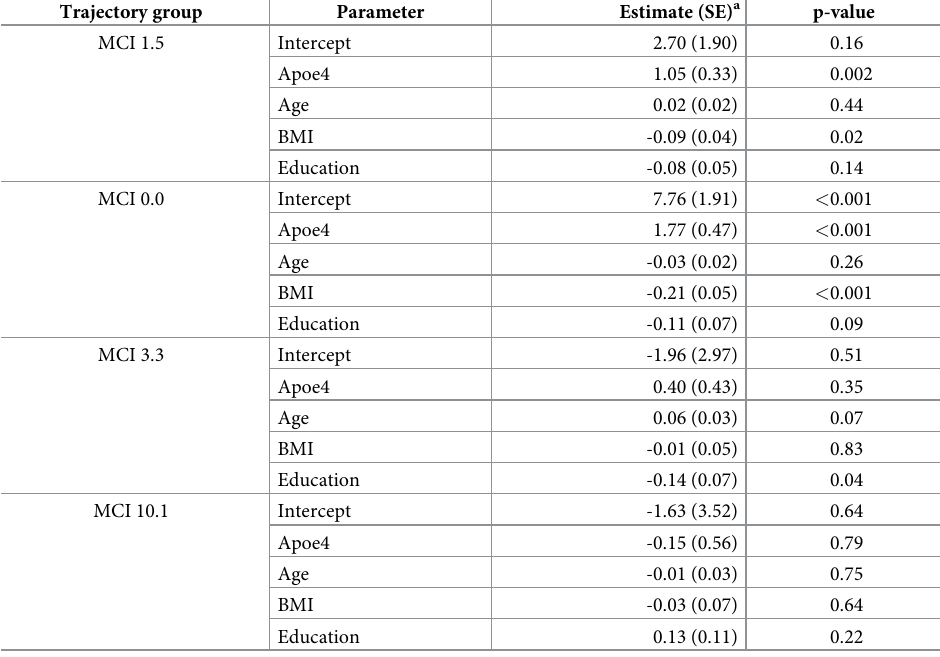
Table 6. Parameter estimates for risk factors associated with each trajectory group in MCI participants.